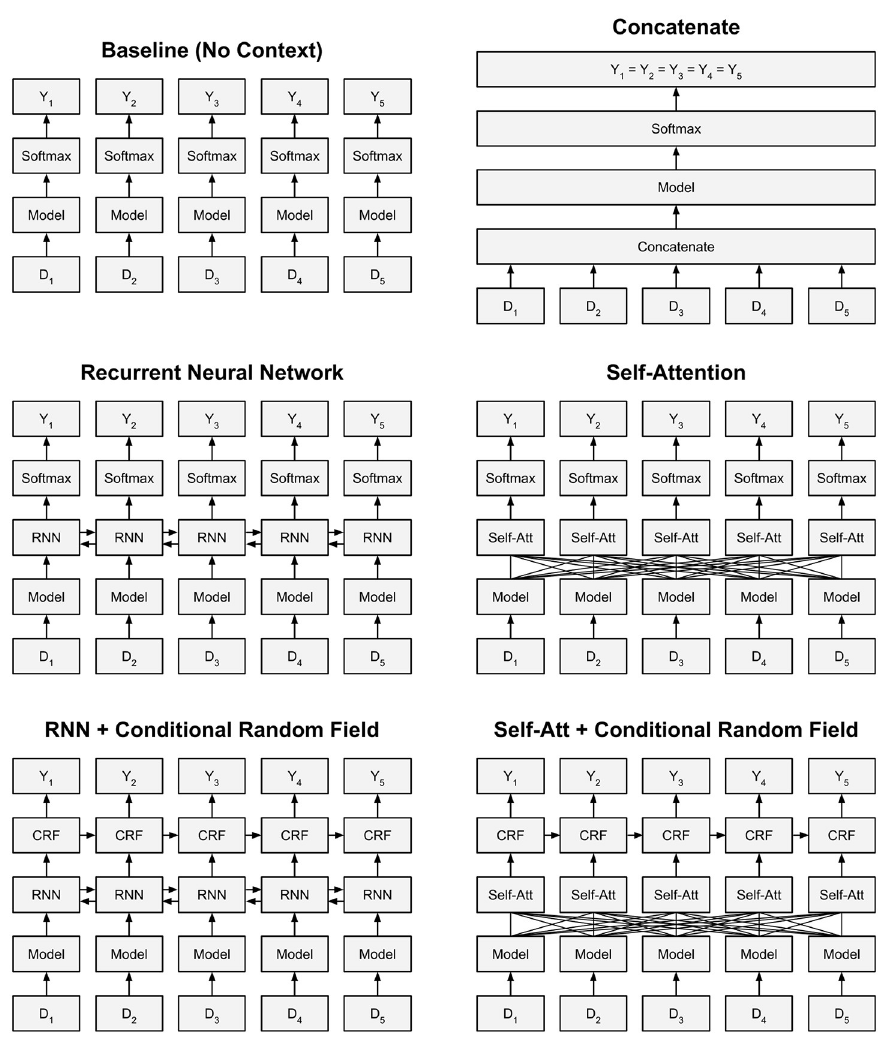
Fig 1. The baseline case for classifying EHRs and the five methods for incorporating case-level context from other reports. In the figures above, “Model” represents an arbitrary deep learning model designed for text classification, the output of which is an embedding representation of the input